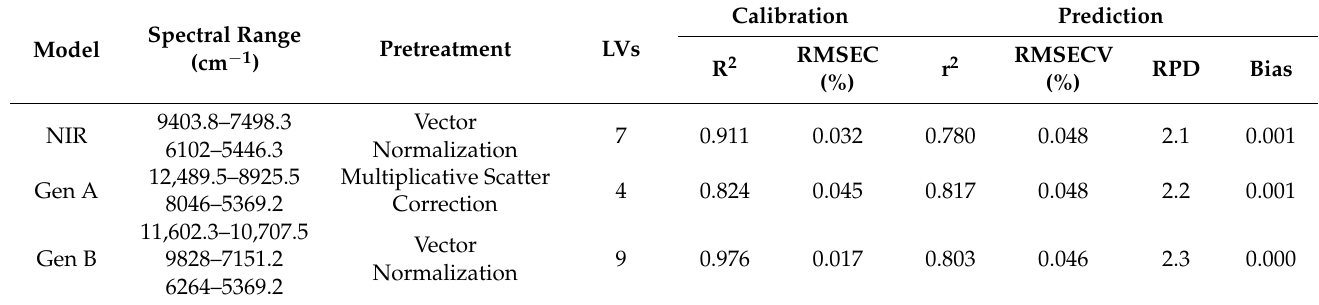
Table 4. PLSR models for mango pur é e TA prediction.